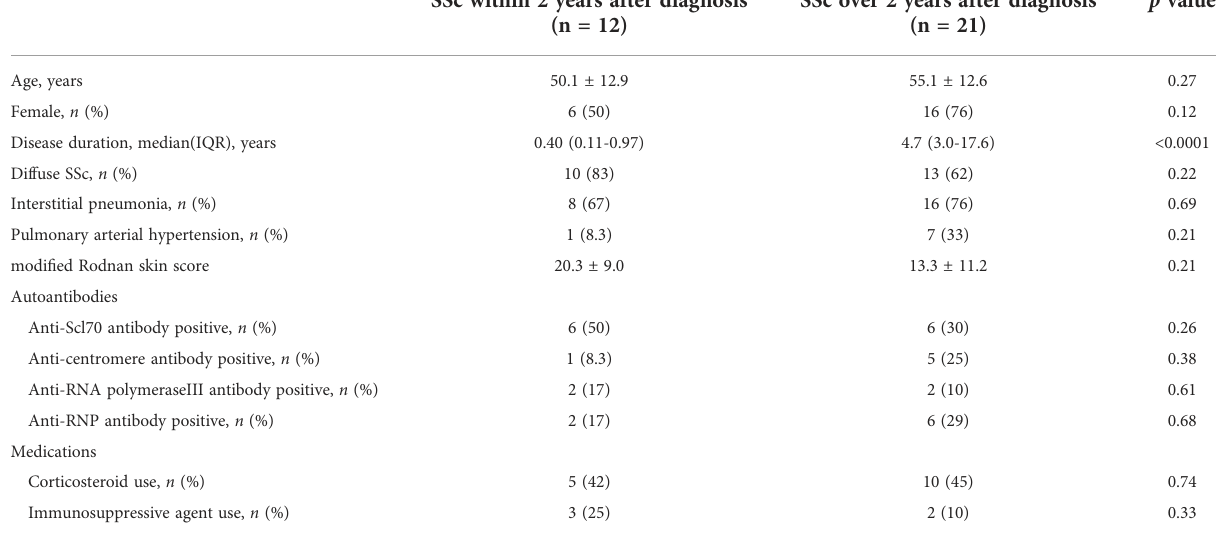
TABLE 1 Demographic clinical data of patients with SSc.